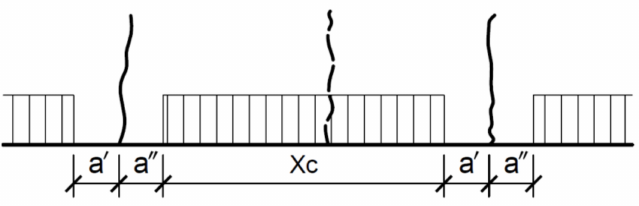
Figure 28. Model of crack formation—passive section a and active section x c . The size of the area surrounding the crack, where stress decreases, is generally a random function. However, in search of a simplified formula, the continuous changes of the crack width were measured using the DIC system. The measurement of the crack width development under loading indicates the linear increase of up to 0.9 of the failure force [42], as shown by examples of cracks no. 2 and 14 (Figure 29) on beam D2M-2 and crack no. 11 on beam C2M-2 (Figure 30). This was confirmed by analyzing the average crack width increase for individual beams, as shown in Figure 31. It can thus be concluded that the course of changes in the section 2a ω length can be assumed as linear.